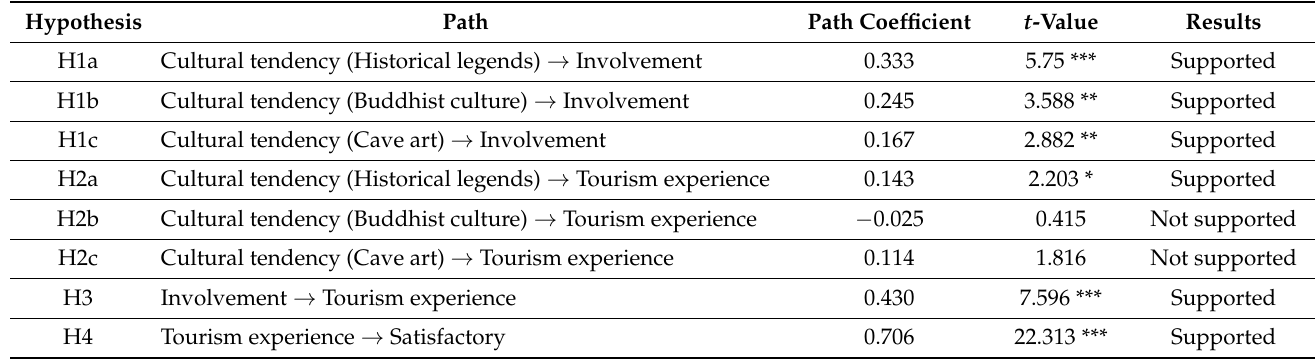
Table 7. Verification of hypotheses.